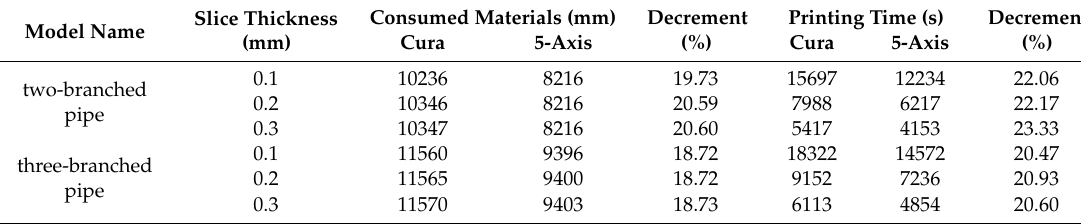
Table 1. Comparison results of slicing e ff